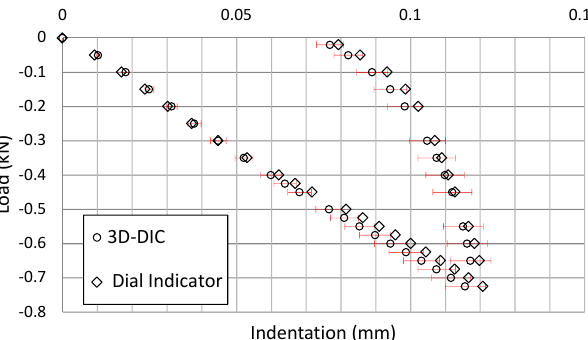
Figure 9. Results comparison using 3D Digital Image Correlation (3D-DIC) and the dial indicator.